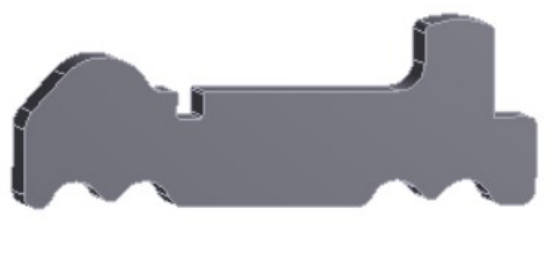
Fig. 2. Finger model of plum